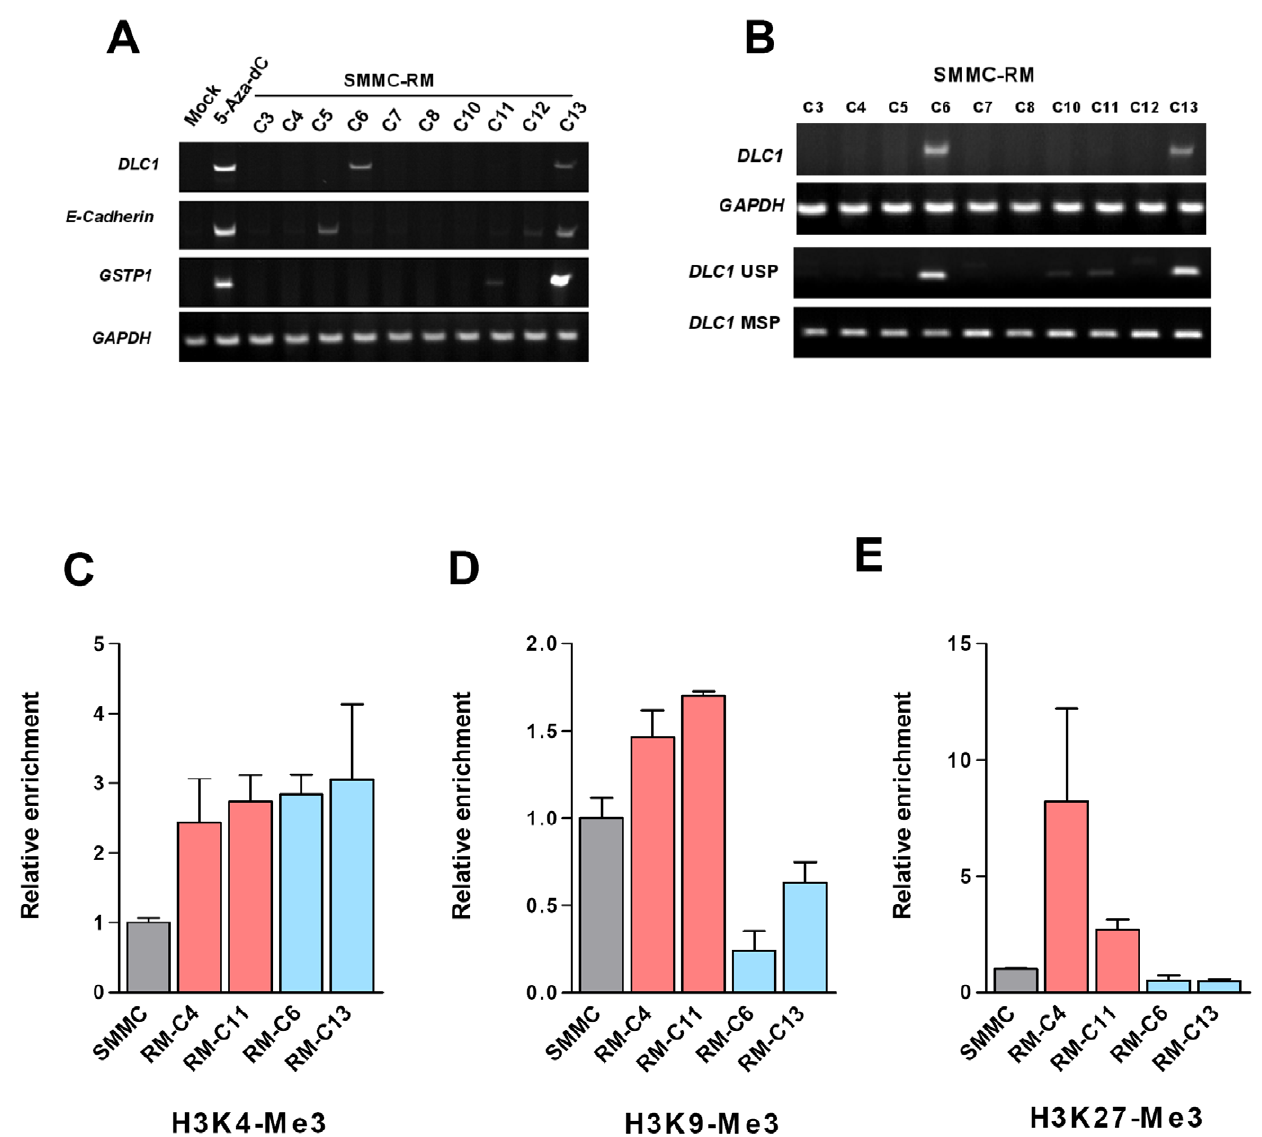
Figure 5. Differential histone modifications associated with heterogeneous DNA methylation recovery. Individual 5-Aza-dC-recovered clones (SMMC-RM-C3 to C13) were established by clonal expansion of SMMC-7721 cells after 5-Aza-dC treatment. (A) mRNA expression of normally hypermethylated tumor suppressor genes ( DLC1 , E-Cadherin and GSTP1 ) in each of the 5-Aza-dC-recovered clones was determined by semi- quantitative RT-PCR. (B) Methylation of DLC1 gene in individual 5-Aza-dC-recovered clones was determined by methylation-specific PCR. Incomplete gene re-silencing of DLC1 , E-Cadherin , and GSTP1 was found in multiple 5-Aza-dC-recovered clones, but the genes involved varied among individual clones. (C) H3K4 tri-methylation (H3K4-me3) was considerably enriched on DLC1 promoter in all 5-Aza-dC-recovered clones when compared with their parental SMMC-7721 cells, indicating that the DLC1 locus in all 5-Aza-dC-recovered clones tested had undergone DNA demethylation during 5- Aza-dC treatment. (D) H3K9 tri-methylation (H3K9-me3) was preserved in DLC1 re-methylated clones, whereas it was significantly reduced in the DLC1 hypomethylated clones (i.e. RM-C6 and C13). (E) H3K27-me3 level was significantly enriched on the DLC1 promoter exclusively in those re-methylated clones (RM-C4 and C11), whereas the H3K27-me3 level remained unchanged in those hypomethylated clones (RM-C6 and C13). These findings suggest that preserved H3K9-me and enrichment of H3K27-me3 level were associated with DNA methylation recovery mediated by DNMT1. Histone modifications on DLC1 promoter region were revealed by ChIP assay using antibody against H3K4-me3, H3K9-me3 and H3K27-me3, respectively. Quantitative data were obtained with real-time PCR and are presented as ‘‘Relative enrichment’’ (mean 6 SEM). Data were obtained from three independent